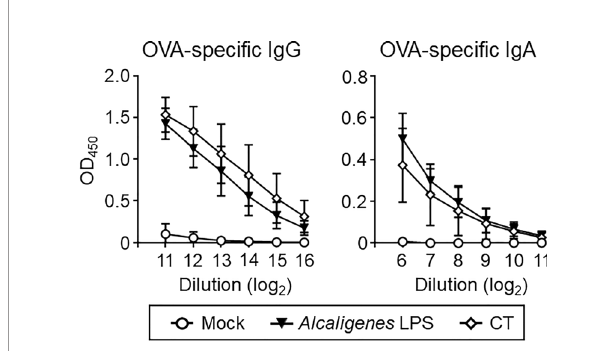
FIGURE 3 | Alcaligenes LPS promotes systemic antibody responses. Mice were nasally immunized three times with OVA alone (Mock) or with OVA plus Alcaligenes LPS or CT; one week after the fi nal immunization, serum was collected to determine OVA-speci fi c IgG and IgA by ELISA ( n = 5 per group). Data are representative of two independent